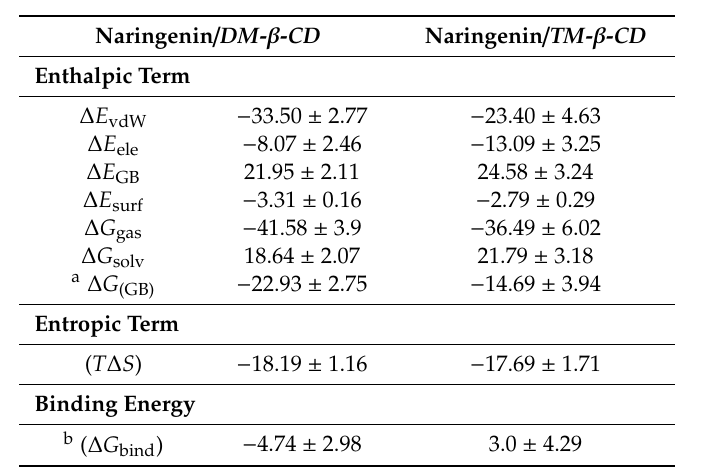
Table 1. Binding free energies (kcal / mole) of the naringenin inclusion complexes with the two methylated β -CDs calculated by MM / GBSA